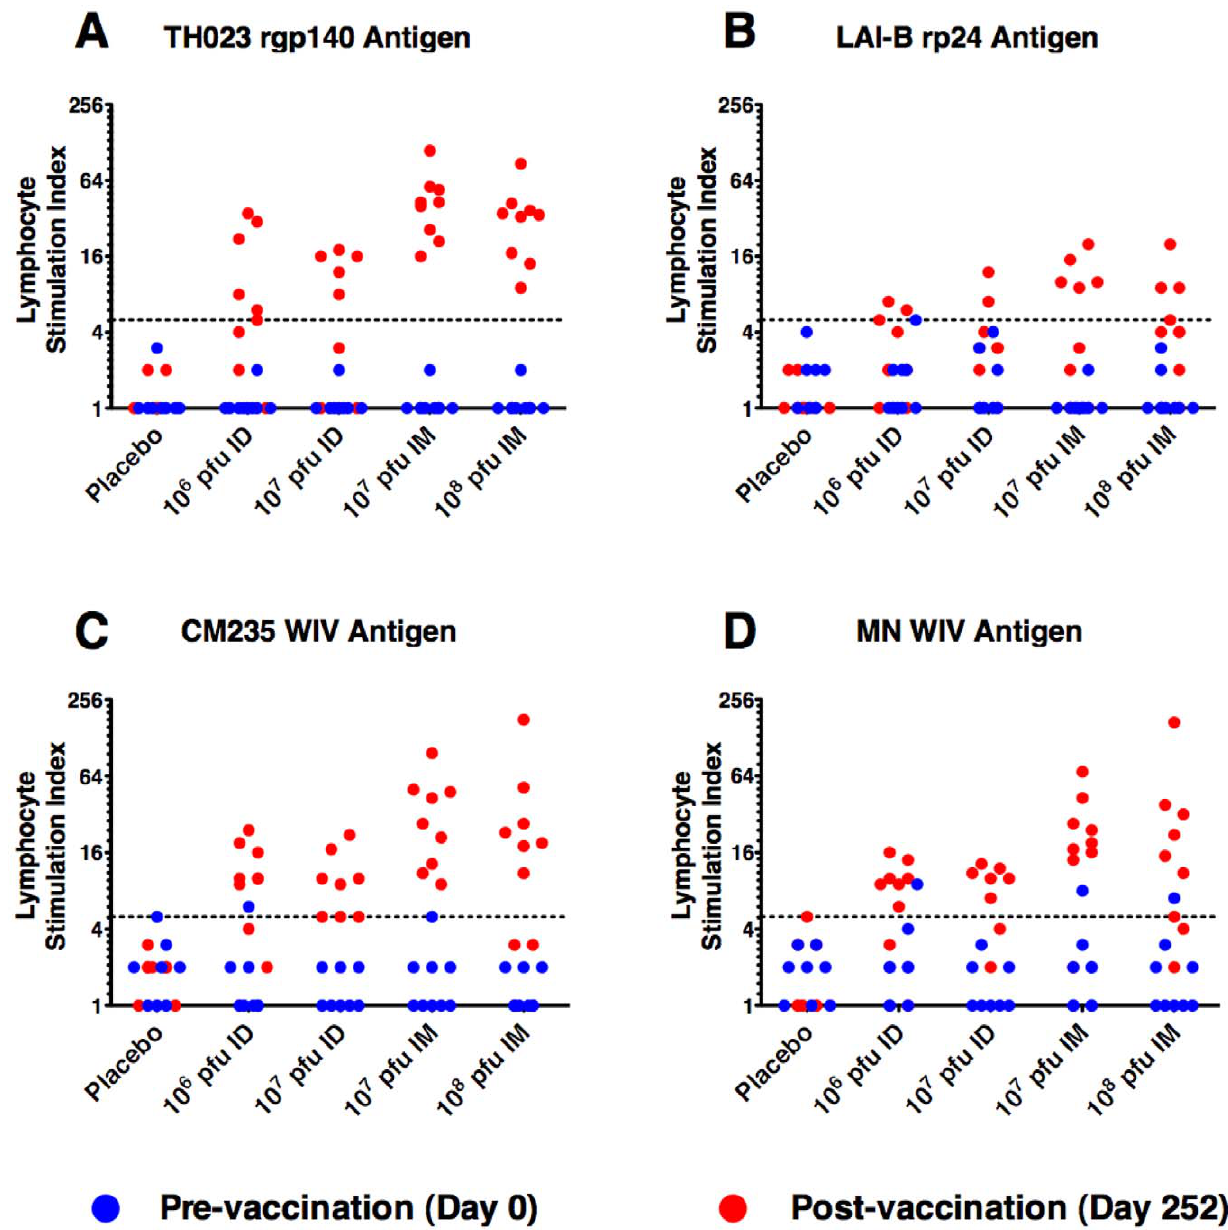
Figure 3. Lymphocyte proliferation responses for each dose and route. Lymphocyte proliferation responses against recombinant proteins (TH023 gp140 and LAI p24) are shown for all doses and routes of vaccination (panels A and B). HIV whole inactivated virus (WIV) antigens CM235 WIV (CRF01_AE vaccine matched isolate) and MN WIV (subtype B heterologous isolate) are shown for all doses and routes of vaccination in panels C and D respectively. The Y-axis represents the LSI (scale=log 2 ) and the dotted line designates an LSI of 5 (cut-off for positive responses). Blue and red circles represent pre- and post-vaccination (day 0 and day 252) samples respectively.